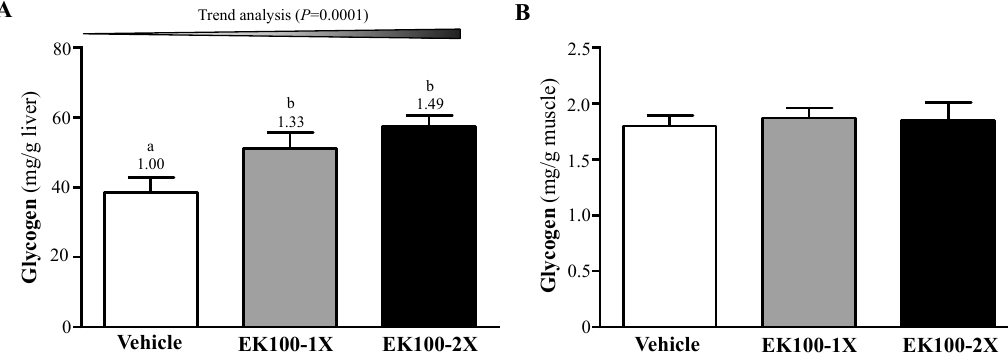
Figure 4. Effect of EK100 on ( A ) liver and ( B ) muscle glycogen levels at rest. Mice were supplemented with vehicle, 10 or 20 mg/kg of EK100 for six-weeks. All of the mice were sacrificed and examined for glycogen levels in muscle and liver tissues 1 h after the final treatment. Data is expressed as mean ± SEM with n = 8 mice in each group. Columns with different letters (a, b) significantly differ by one-way ANOVA ( p < 0.05).